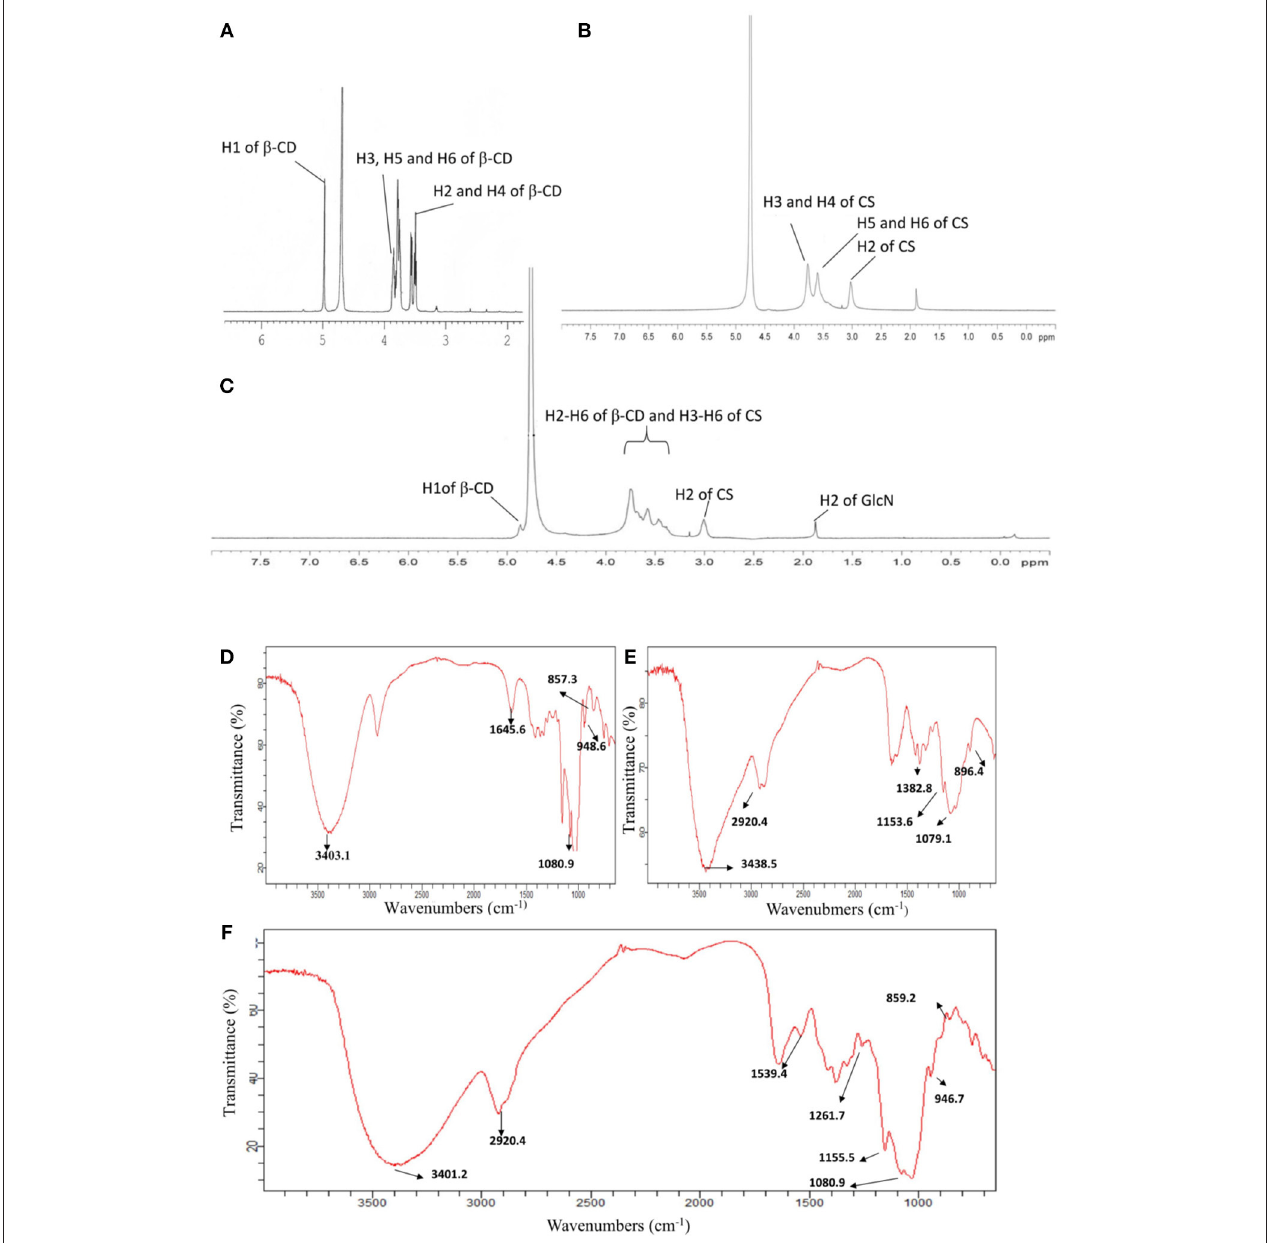
FIGURE 2 | 1 H NMR spectra of β –CD (A) , CS (B) , and CD-g-CS (C) . FT-IR spectra of β -CD (D) , CS (E) , and CD-g-CS (F) .